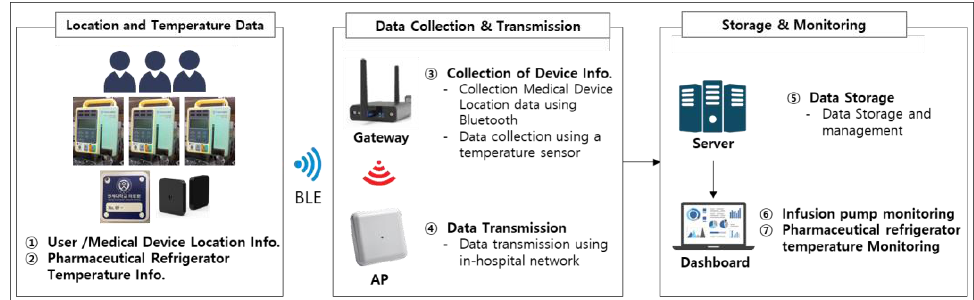
Figure 6. Sigfox Network Field Setting for Monitoring Patient Location.